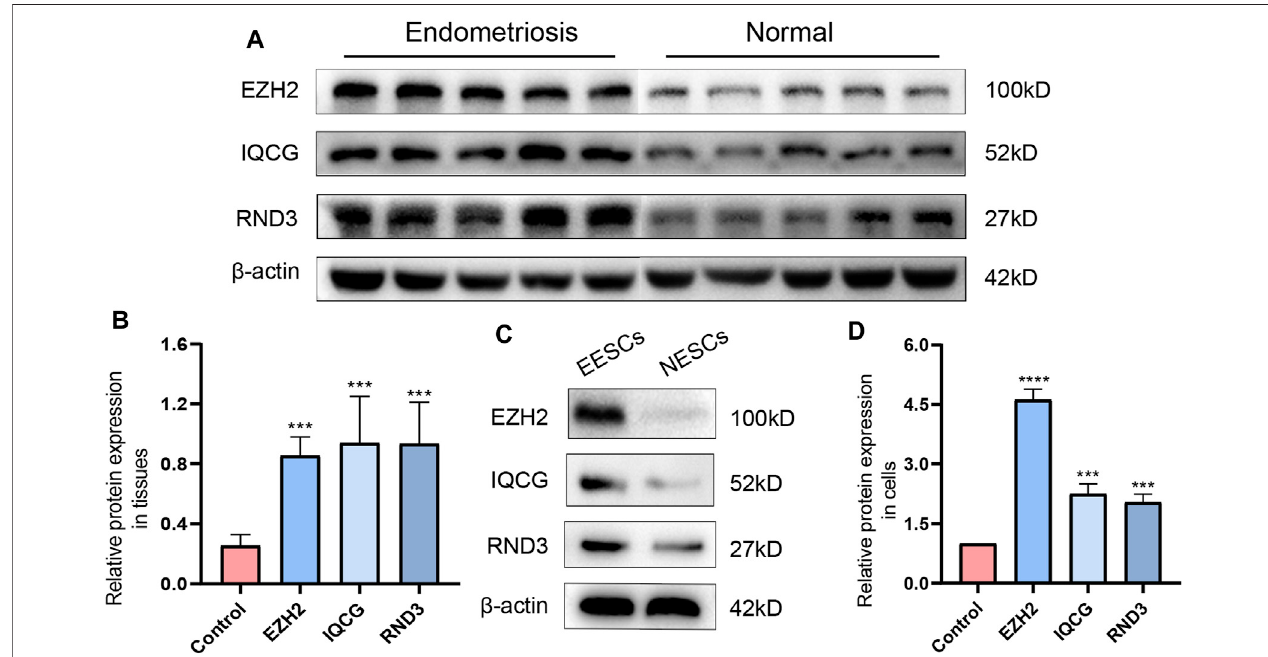
FIGURE 8 | The differences in the expression levels and quantitative analysis of EZH2, IQCG, and RND3 by Western blotting between the endometriosis tissues and the control tissues (A,B) , those between NESCs and EESCs (C,D) .